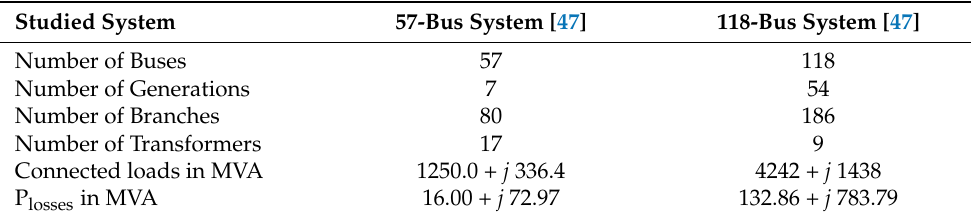
Table 1. The significant specifications of the studied systems.